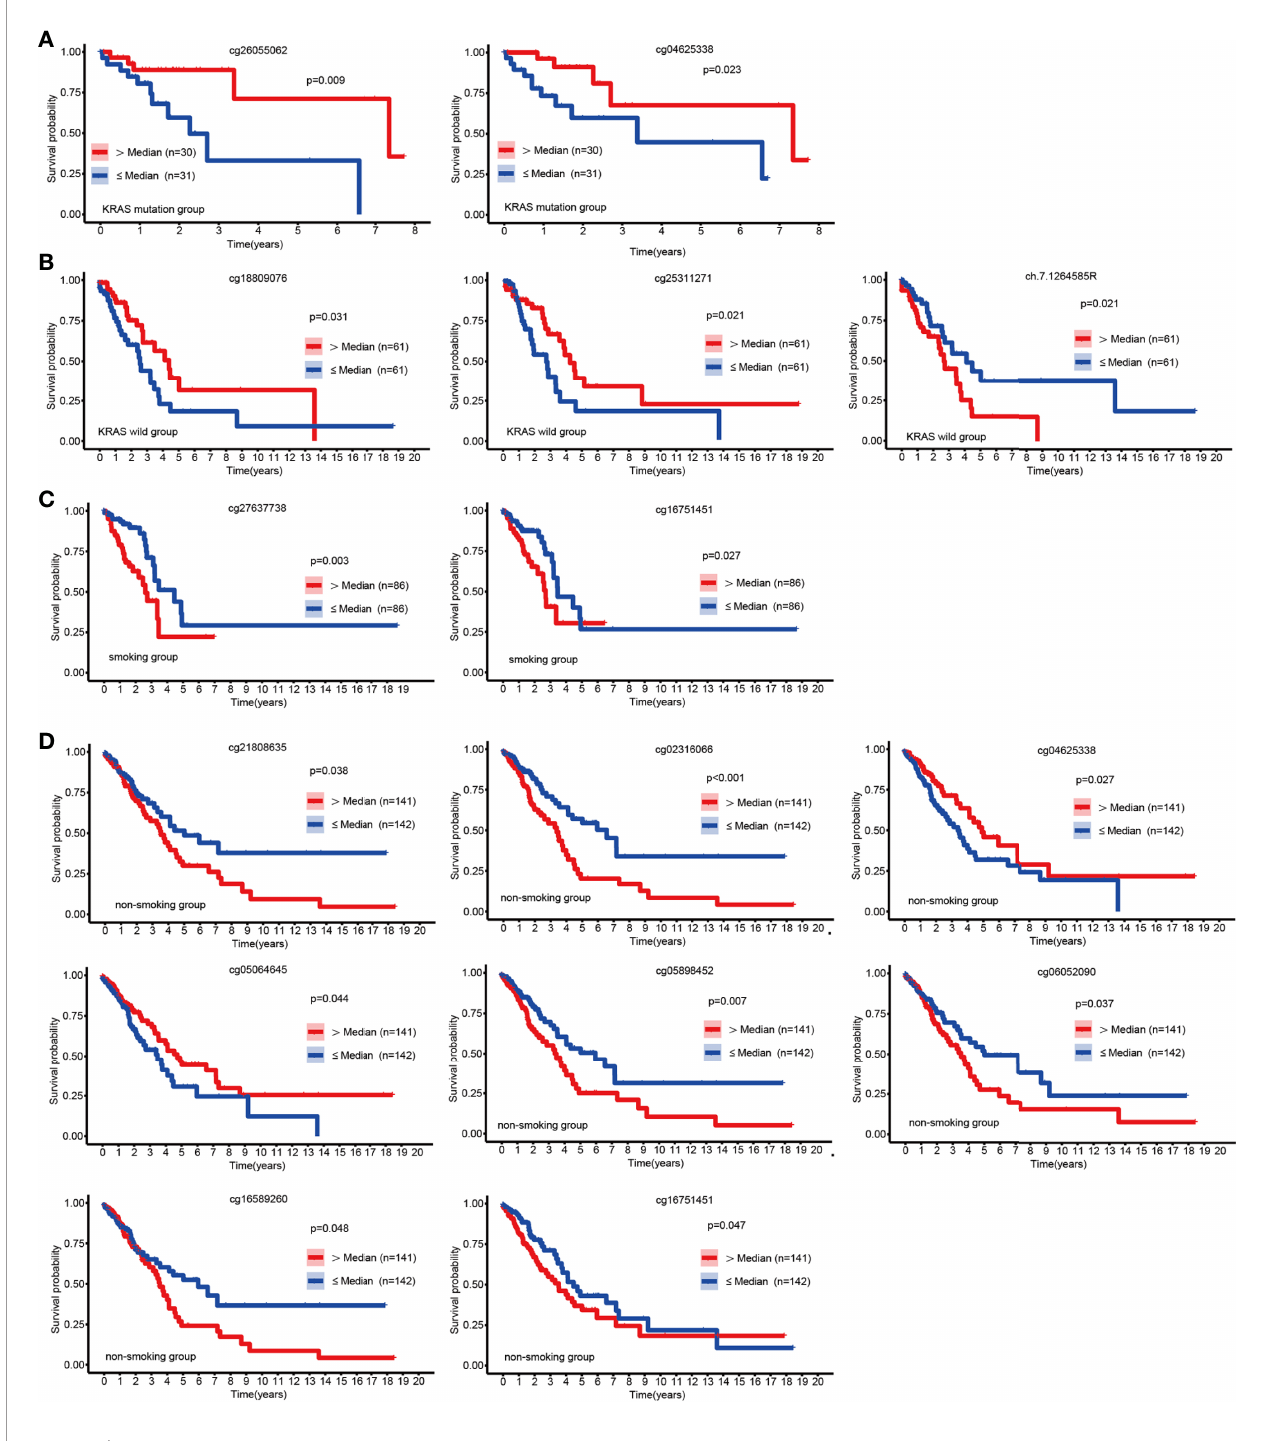
FIGURE 3 | KM curves of EGFR CpG sites. Kaplan-Meier analysis of the overall survival rate of LUAD patients based on the KRAS mutation group (A) , KRAS wild- type group (B) , smoking group (C) and the non-smoking group (D)